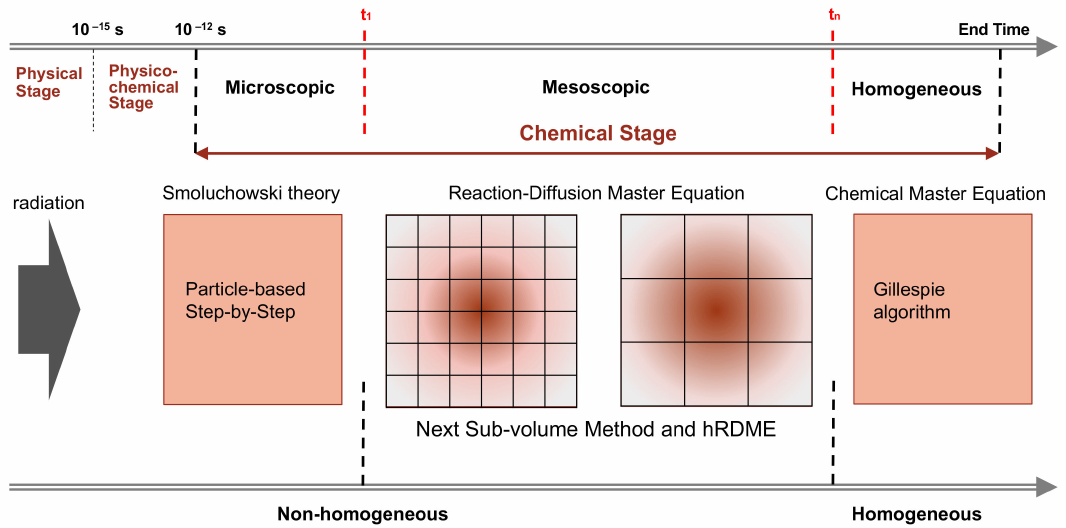
Figure 6. The simulation scheme of the combination of the particle-based SBS model with the compartment-based model that uses the RDME (SBS-RDME